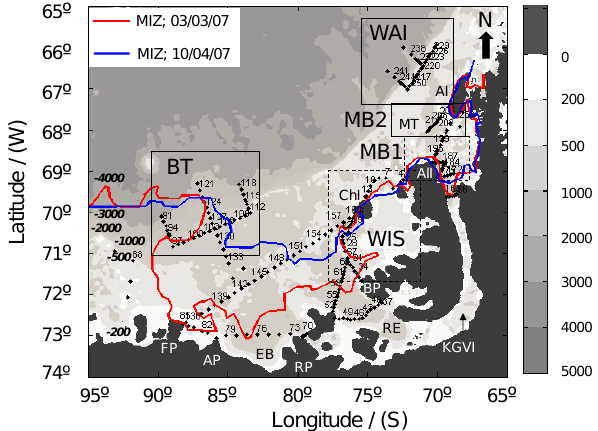
Fig. 1. Area of study for cruise JR165 in the Bellingshausen Sea during summer 2007. Black dots indicate the location of the CTD stations occupied during the cruise. The location of the marginal ice zone (MIZ) from AMSR-E satellite images is also shown at the beginning and end of the cruise. Main coastal features (from west to east): FP, Fletcher Peninsula; AP, Allison Peninsula; EB, Eltanin Bay; RP, Rydberg Peninsula; RE, Ronne Entrance; BP, Beethoven Peninsula; KGVI, King George VI Sound; ChI, Charcot Island; AlI, Alexander Island; MT, Marguerite Trough; AI, Adelaide Is- land. Stations in the WSIZ are outlined by dashed-line rectangles: WIS, Wilkins Ice Shelf and MB1, Marguerite Bay 1; stations in the permanent open ocean zone (POOZ) by solid line rectangles: BT, Belgica Trough; MB2, Marguerite Bay 2 and WAI, west of Ade- laide